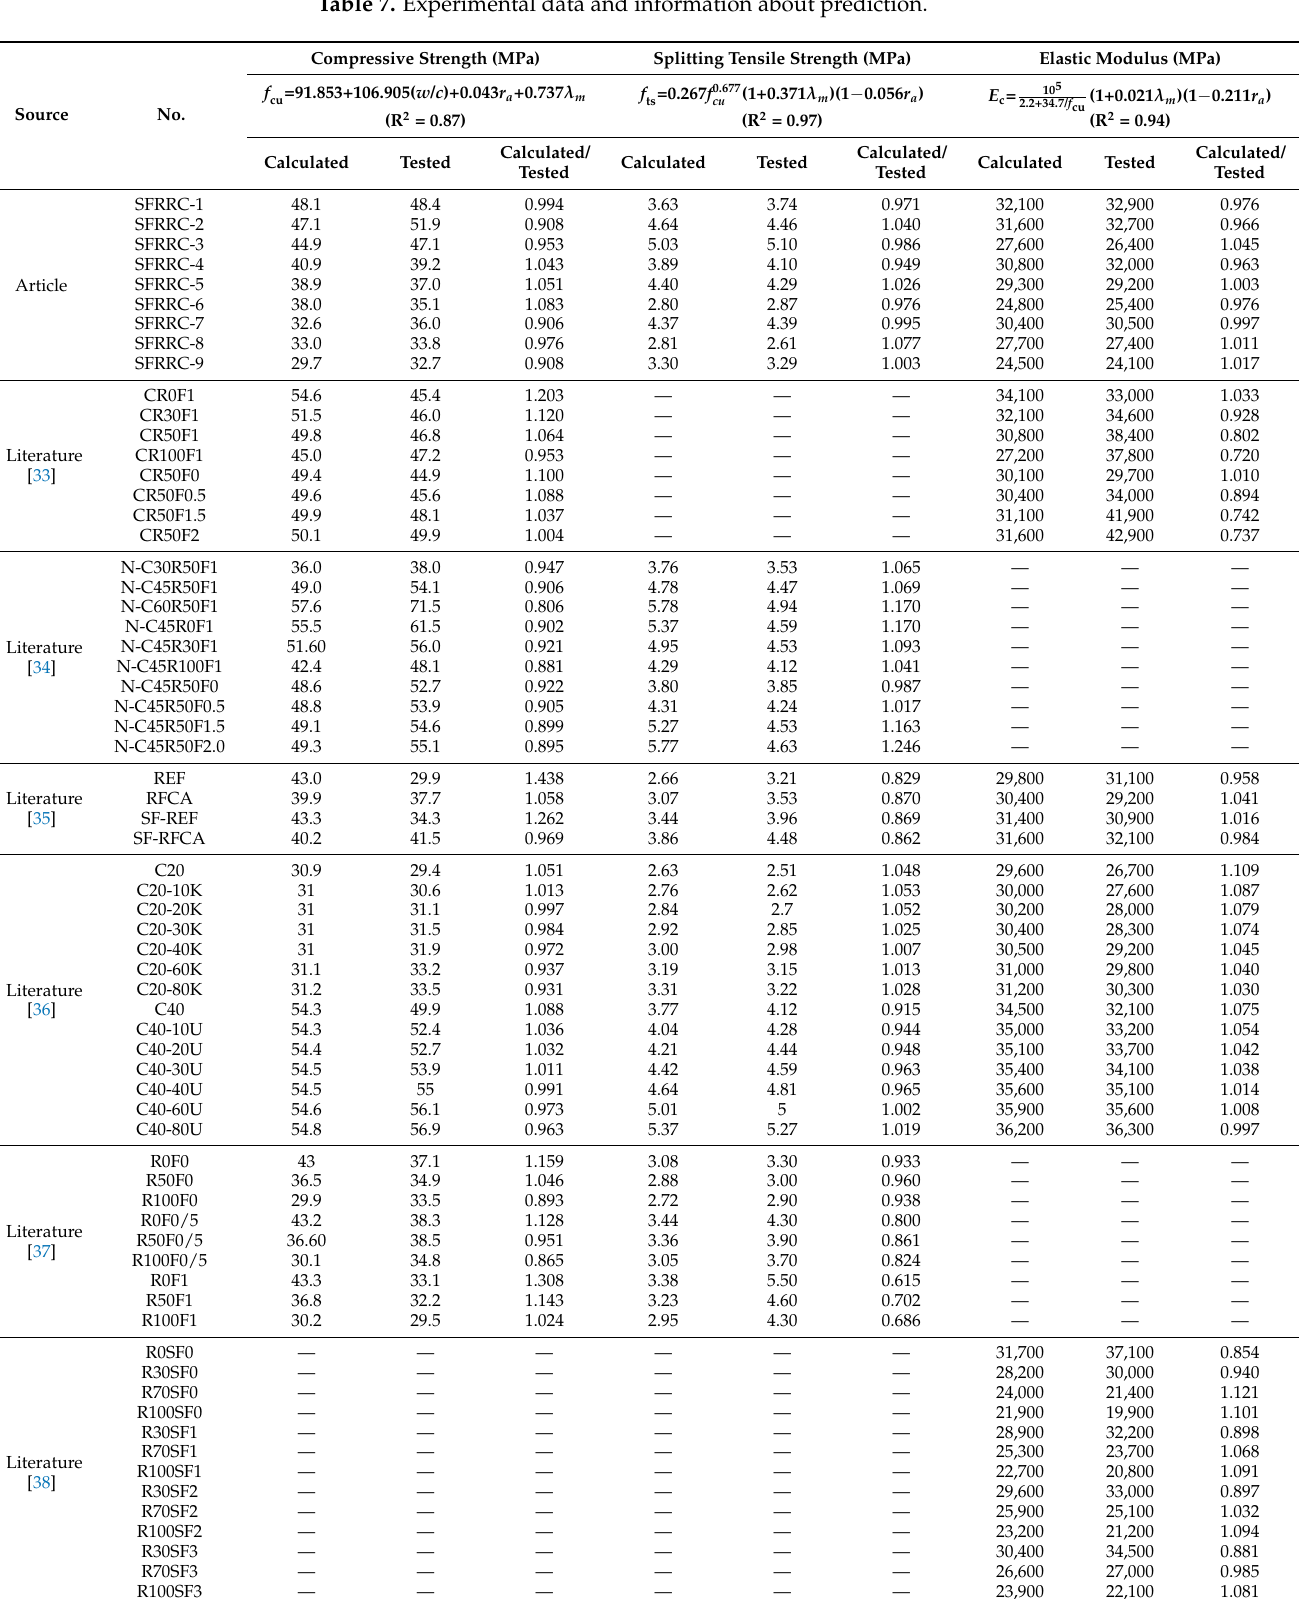
Table 7. Experimental data and information about